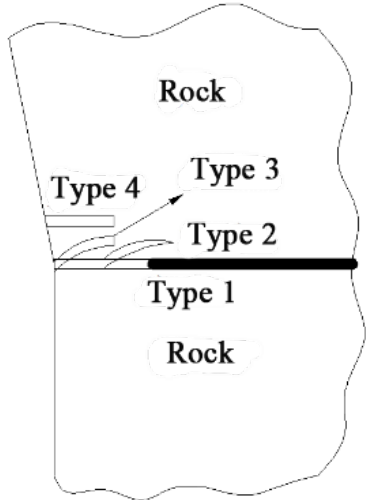
Figure 1. Three types of interfaces: ( a ) fully bonded interface; ( b ) debonding interface; ( c ) contact interface.